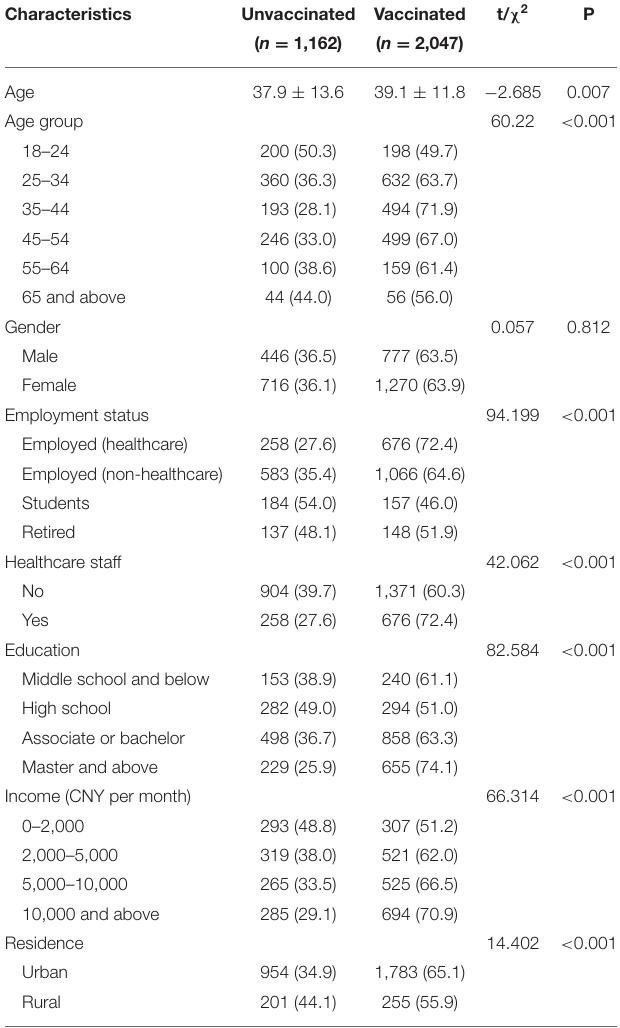
TABLE 1 | The basic characteristics of the 3,209 respondents in the